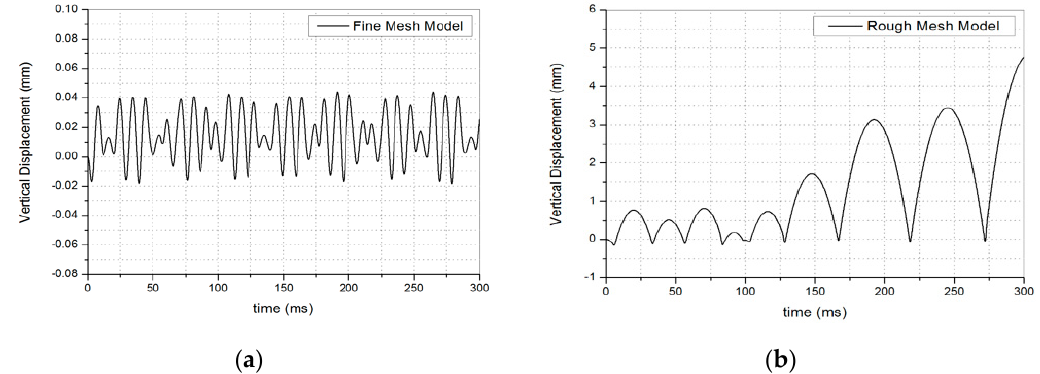
Figure 5. ( a ) Vertical displacement between wheel and rail (fine mesh model) and ( b ) Vertical displacement between wheel and rail (rough mesh model).